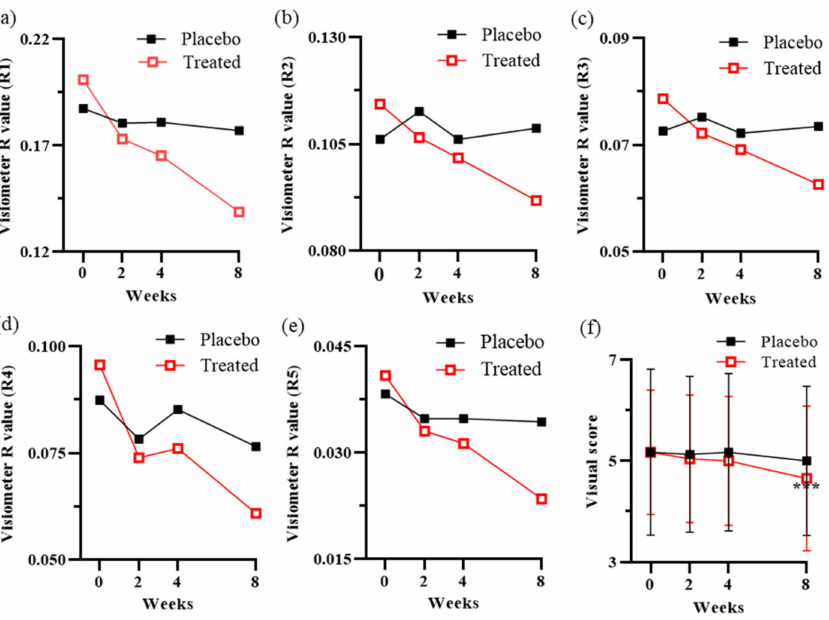
Figure 6. Differences of five visiometer R values quantified using Skin-Visiometer SV600 and visual score after treatment with a cream including I. indigotica leaf extract for 8 weeks between placebo and treated groups to evaluate anti-wrinkle activity. ( a ) R1: skin roughness. ( b ) R2: maximum roughness. ( c ) R3: average roughness. ( d ) R4: smoothness depth. ( e ) R5: arithmetic average roughness. ( f ) Visual scores graded by dermatologist were followed Gaussian distribution by the result of Ryan–Joiner normality test, and a significant difference *** of visual scores on the treated skin surface after 8 weeks treatment was proved by repeated-measures ANOVA at the 0.001 significance level.